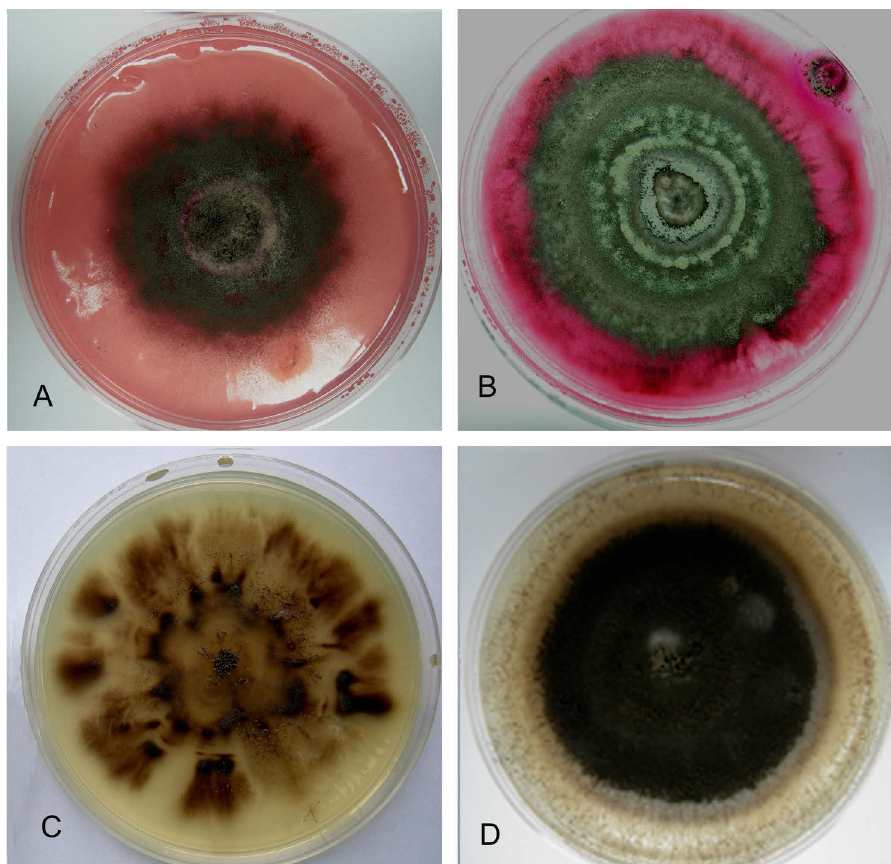
Fig. 1. Colonies of Cephalotrichum stemonitis on different media: A – on RBC; B – on DRBC; C – on YMA; D – on